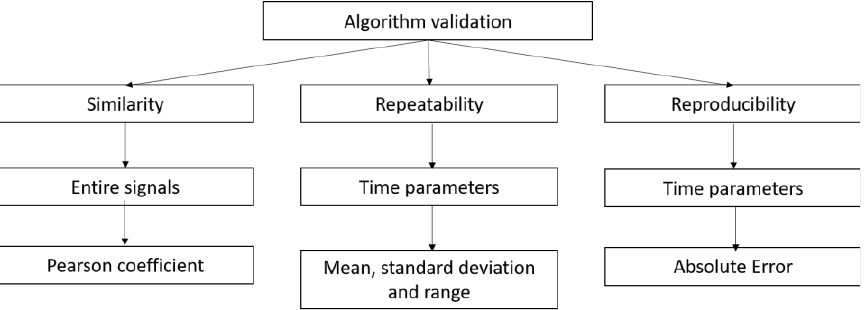
Figure 13. Validation scheme of the algorithm.